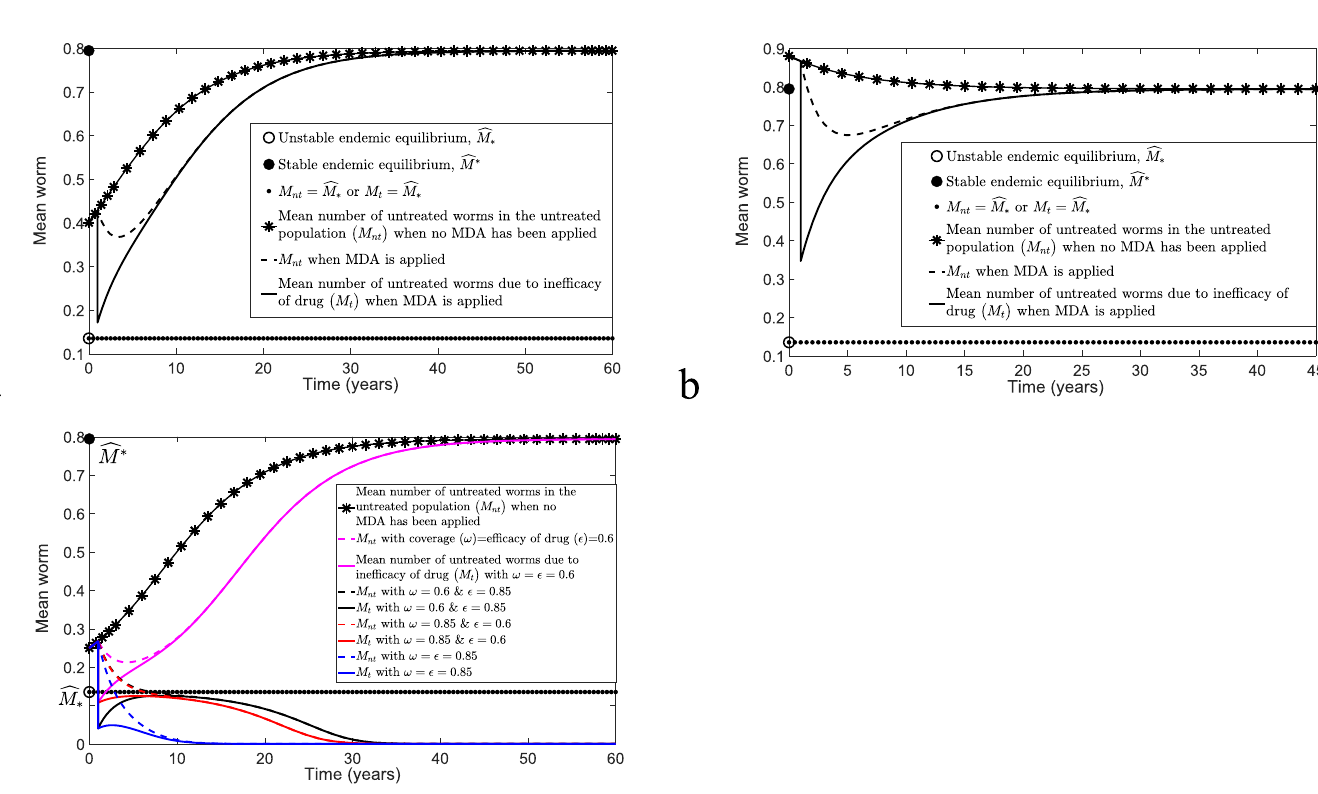
> b M , � and ω values, with k = 0.05 and R 0 = 2. (a) ω = � = 0.6 and b M 0 � �